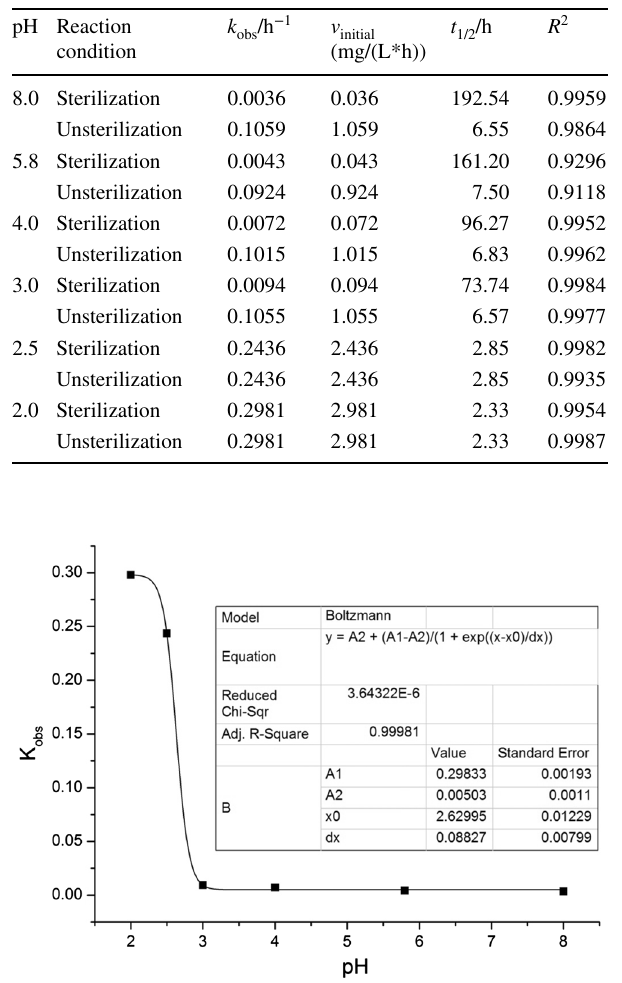
obs and pH in the reaction on sterili-